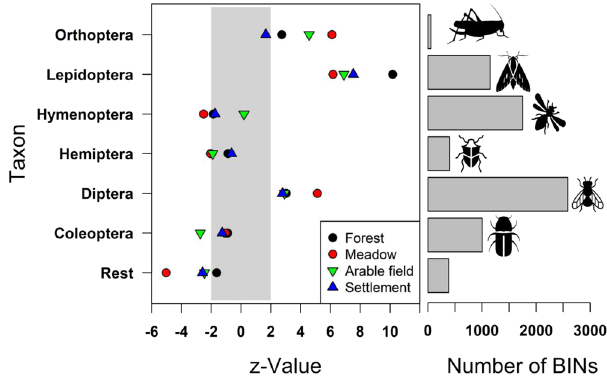
Fig. 4 Taxonomic group and habitat-speci fi c standardized estimates of BIN richness to explain total biomass in a generalized linear mixed model. The horizontal bars on the right show the total number of BINs per group. Values for BIN richness and total biomass were log-transformed. The vertical gray bar on the left indicates the area outside of which effects are signi fi